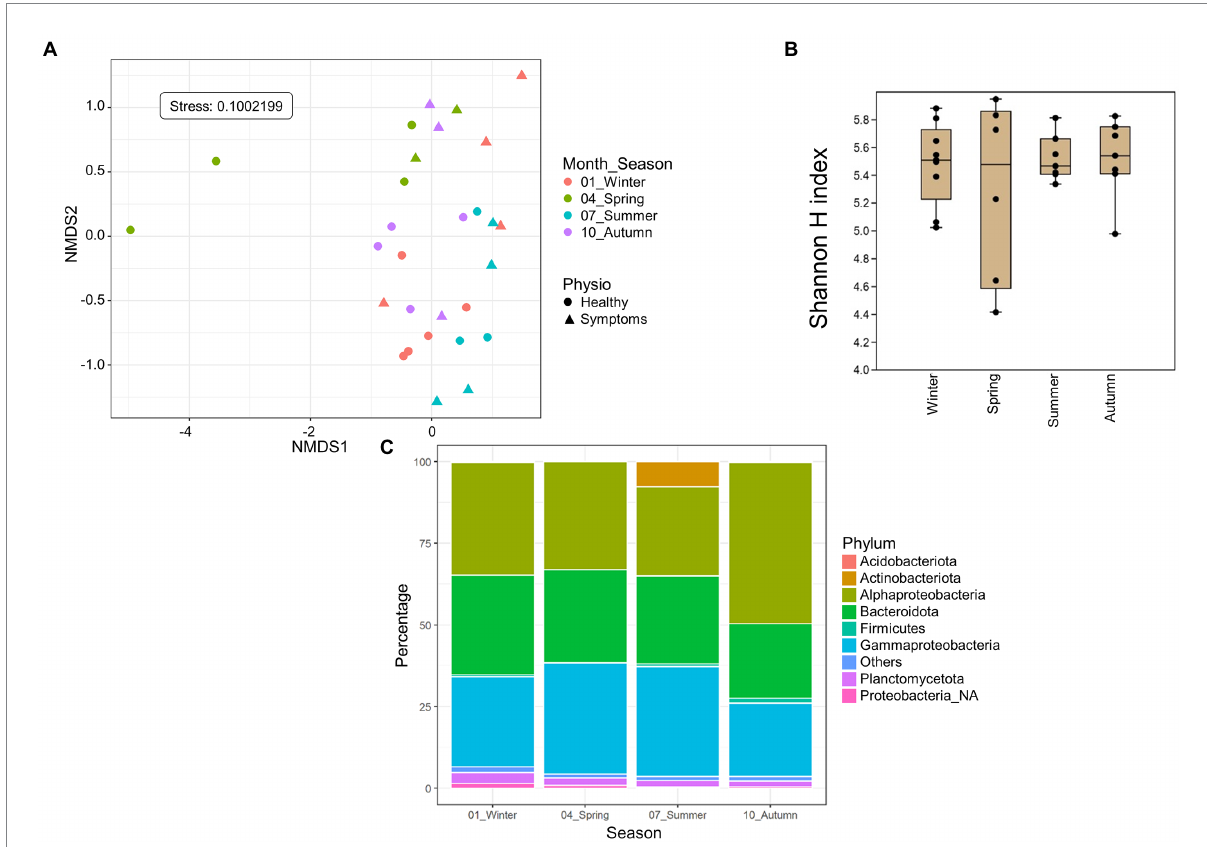
FIGURE 4 Season analyses. Only Roscoff samples were used to assess the impact of the season. (A) NMDS analysis of the microbiome composition. Results show a separation of the samples depending on the sampling season (PERMANOVA, p = 0.001). (B) Box plot of alpha-diversity (Shannon H index) across different sample types calculated at the ASV level. Error bars correspond to the range; n = 30; conditions do not differ significantly (Kruskal– Wallis test, p > 0.05 ). (C) Seasonal differences in microbiome composition in Roscoff at the phylum level. Bars show the relative abundance of 16S rRNA gene metabarcoding sequences; all phyla were detected in all sample types, and only their relative abundance varied. Proteobacteria_NA : unclassified